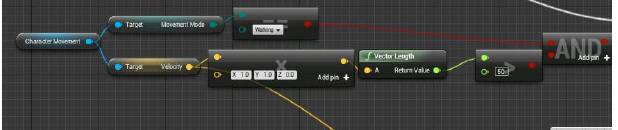
Figure 2. Unreal Engine’s Blueprint